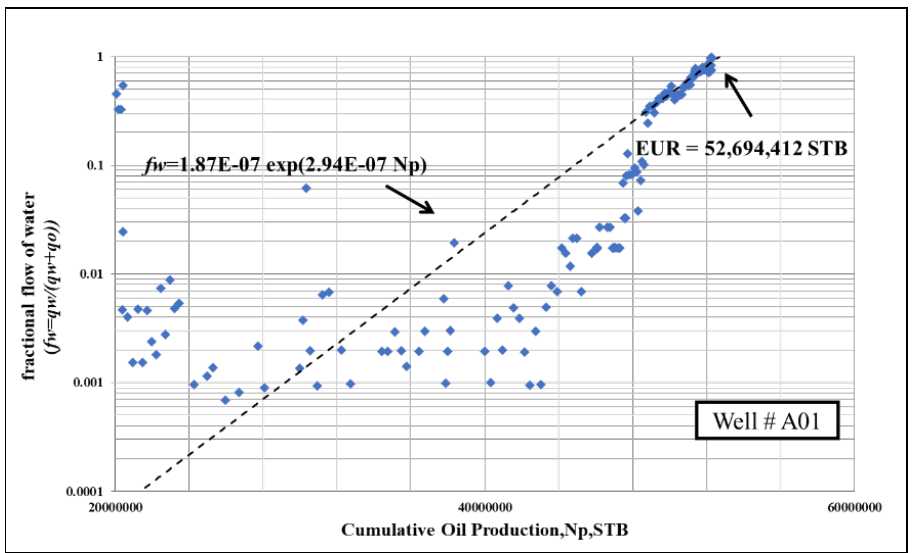
Figure 11. Fractional flow of water versus cumulative oil production for well